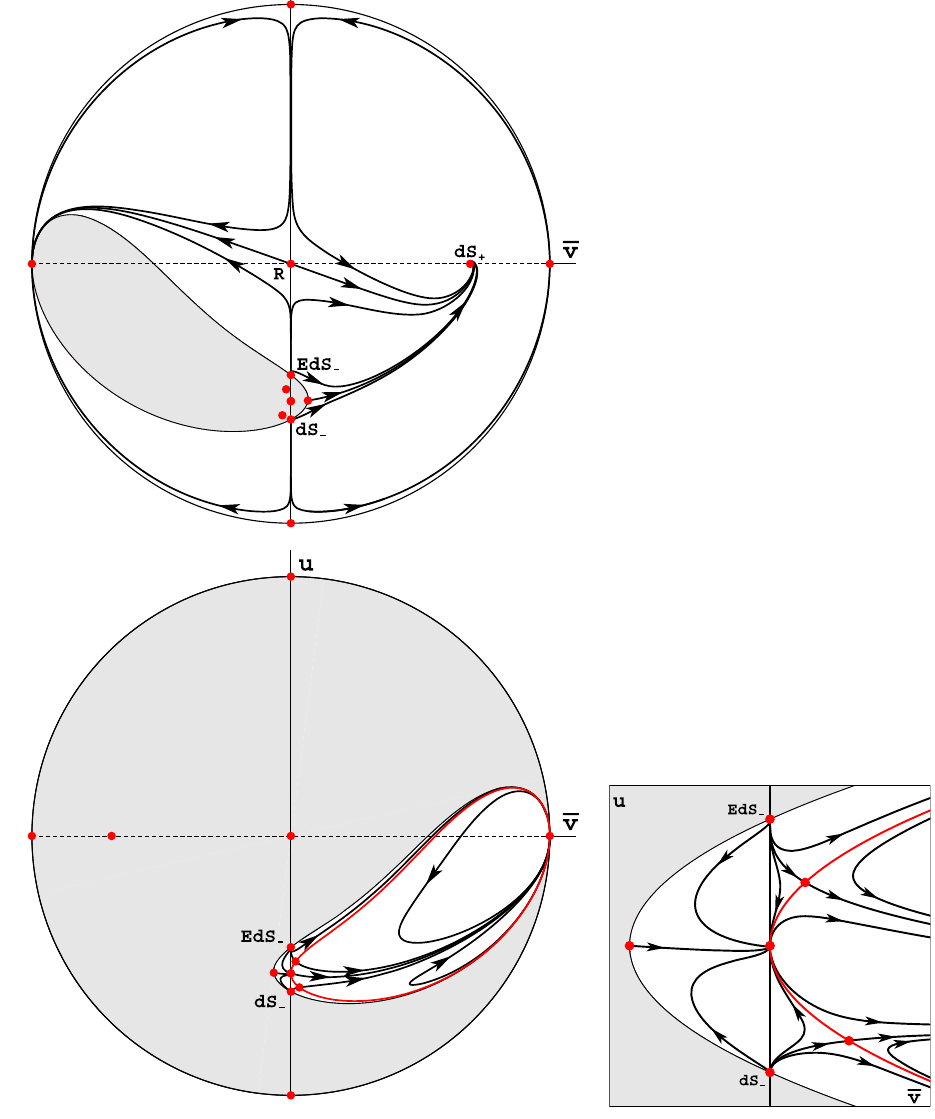
Fig. 1 The phase space diagrams representing evolutional paths of the decoupled part in the ( u , ¯ v) dynamical variables of the system (22) with λ = 2 for the canonical ε = + 1 (top) and the phantom ε = − 1 (bottom) scalar fields. The shaded regions of the phase space are unphysical where the energy conservation condition (21) is negative. Direction of arrows on the phase space trajectories indicates expansion of the universe. For λ > − 1 both the Einstein–de Sitter state EdS − and the de Sitter state dS − are unstable with respect to expansion of the